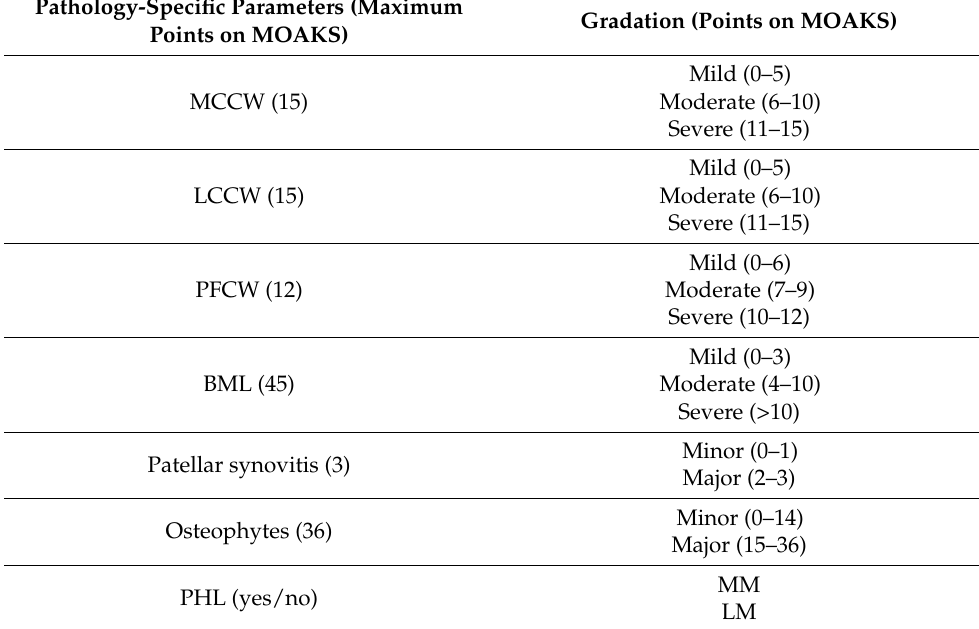
Table 2. Baseline MRI features of the study population assessed by the MRI osteoarthritis knee score (MOAKS)